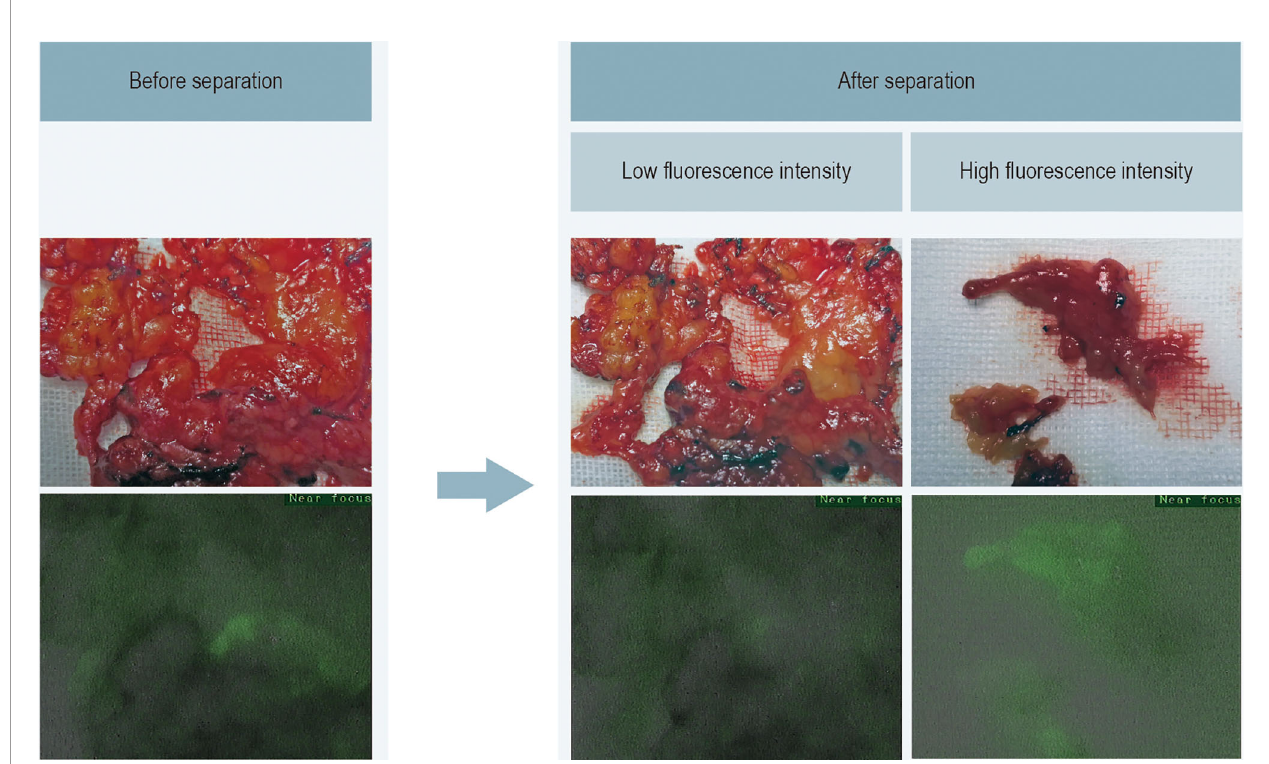
FIGURE 4 | Fluorescence imaging of lateral neck lymph node dissection specimens.